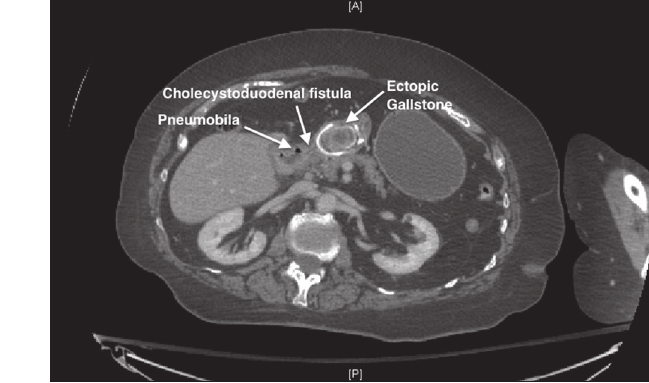
Figure 2) Computed tomography scan. Gallstone in the duodenum, chole- cystoduodenal fistula and